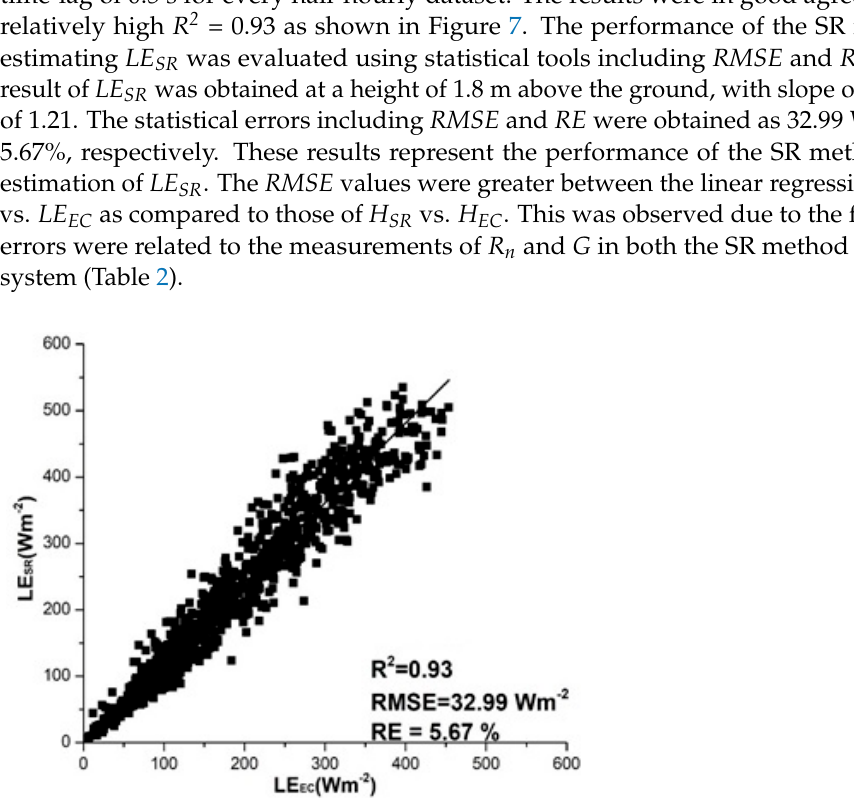
Figure 7. Half-hourly estimated LE SR vs. LE EC under unstable conditions. Table 2. Experiment instruments and installation.